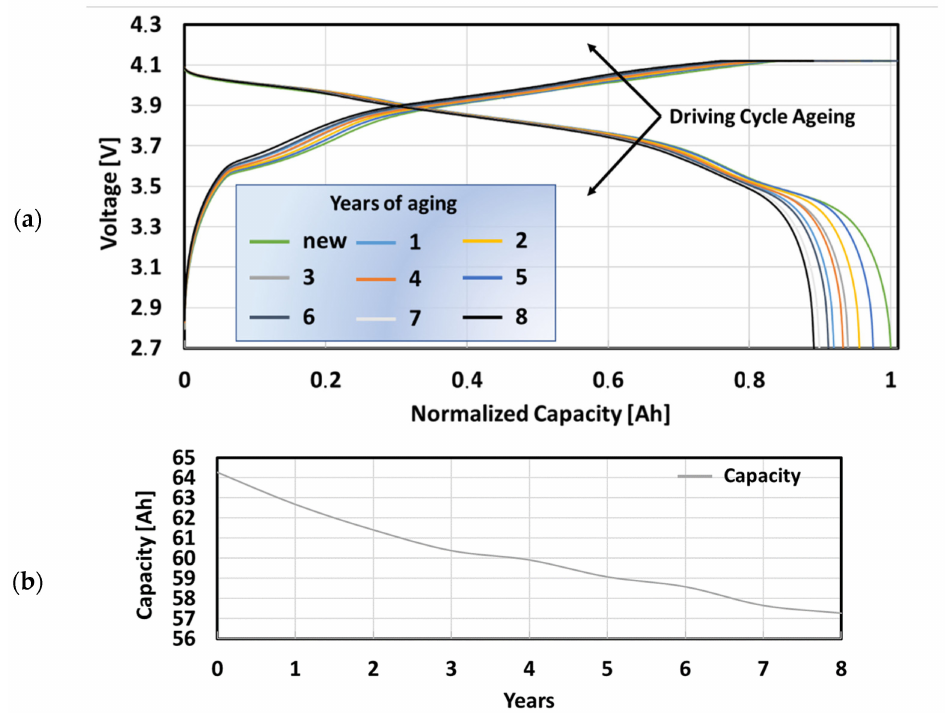
Figure 9. ( a ) Charge and Discharge time diagram during WLTP CLASS 3B driving cycle at 25 ◦ C from BOL to 8 test years of ageing ( b ) Capacity drop after battery